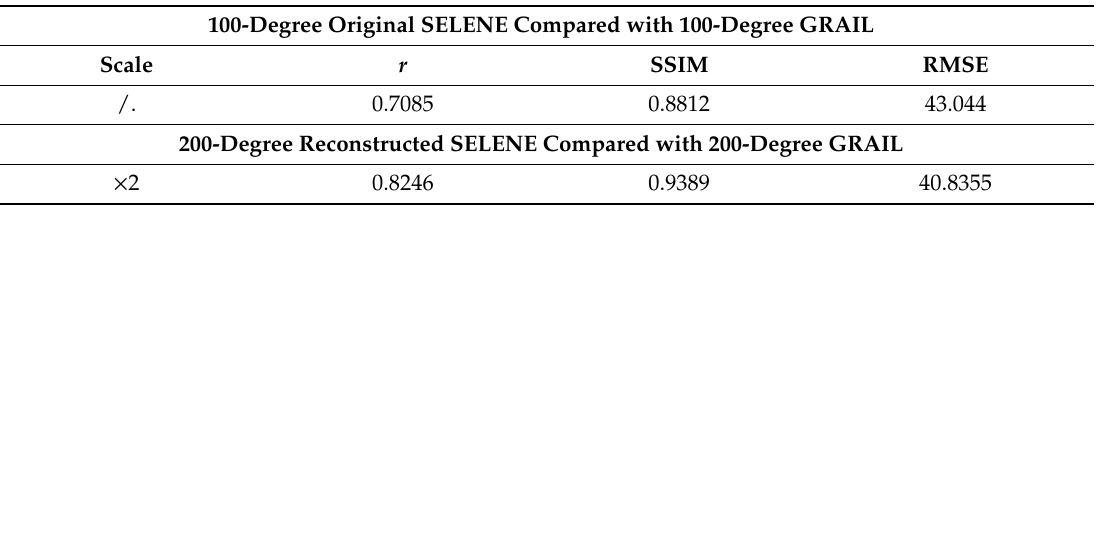
Table 3. Generalization performance on SELENE